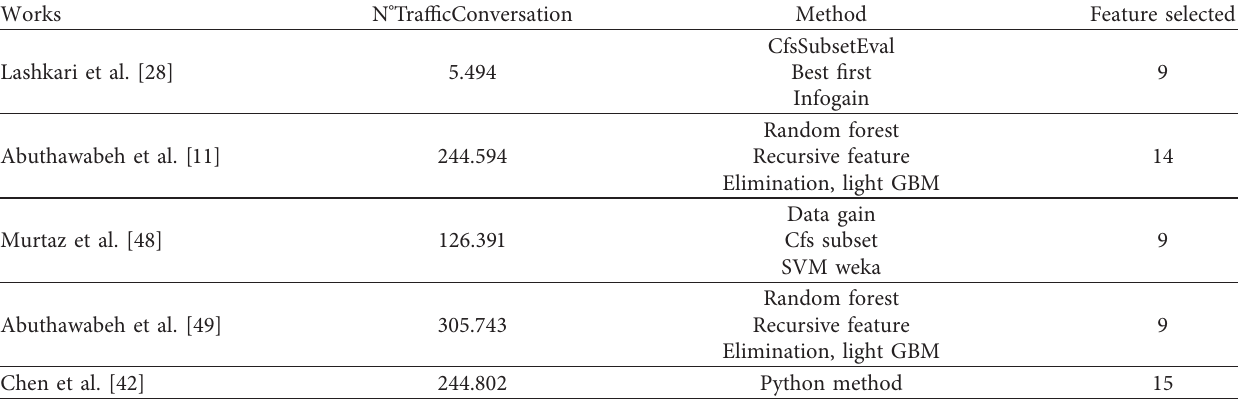
Table 15: Total number of benign software and malware network traffic conversations for each related